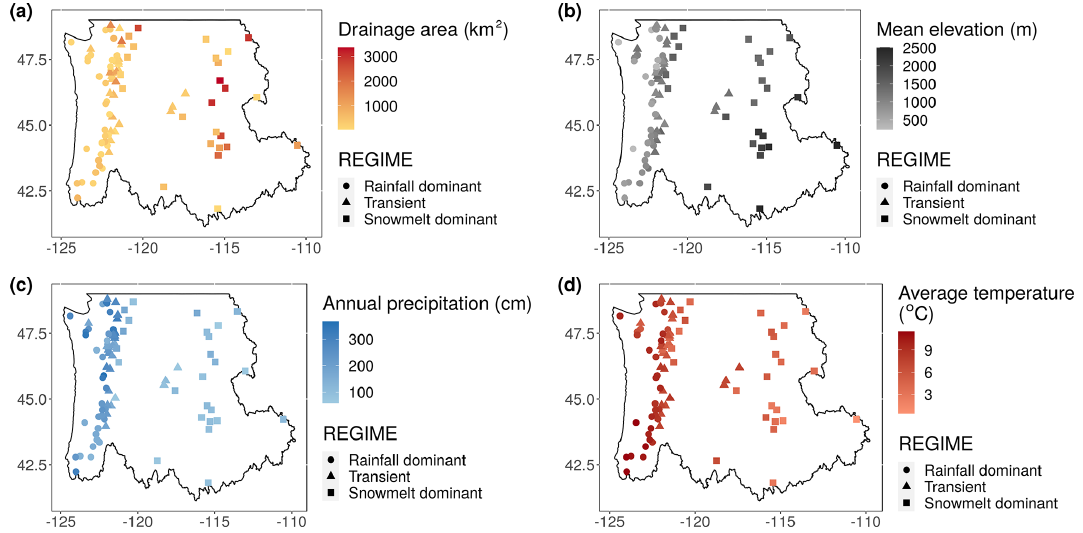
Figure 3. Gauge locations with a color gradient indicating variations in (a) drainage area (km 2 ), watershed mean elevation (m), (c) annual precipitation (cm), and (d) annual mean temperature ( ◦ C). Table 1. Number of USGS gauges used in the study for each flow regime, mean watershed elevation, drainage area, annual precipitation, and annual mean temperature